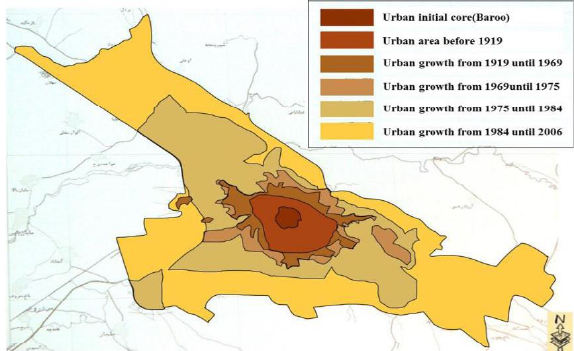
Figure 7. Periodic Growth of Tabriz City since the Formation of Initial Core until 2006 (Kheyroddin, et.al,